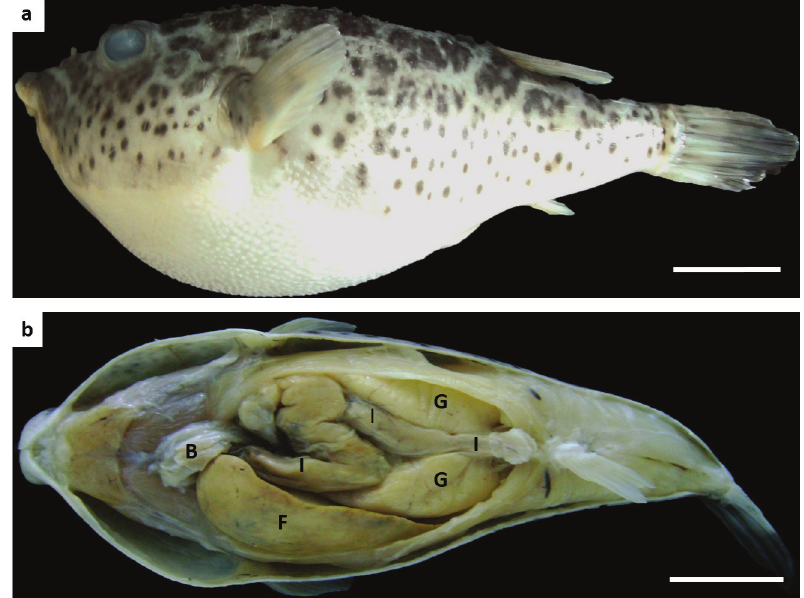
Figure 1 - Overview of Sphoeroides testudineus. – a. Lateral view. – b. Ventral view evidencing the abdominal pouch (P), intestinal tract (I), liver (L), gonads (G), rectum (R). Bar: 0.5